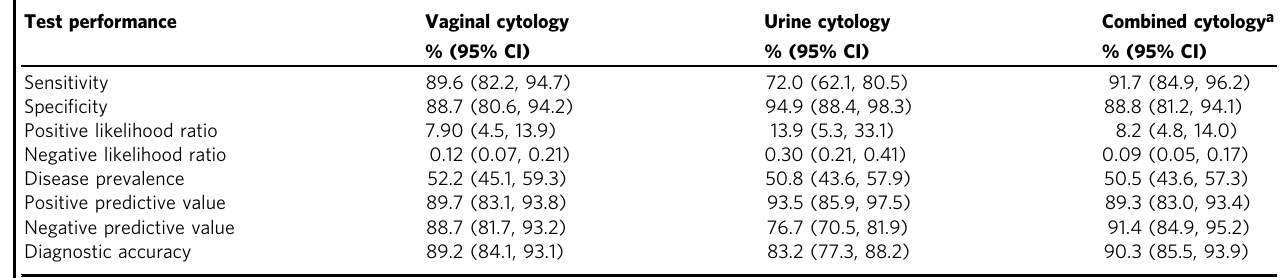
Table 3 Diagnostic accuracy of urogenital cytology for gynaecological cancer